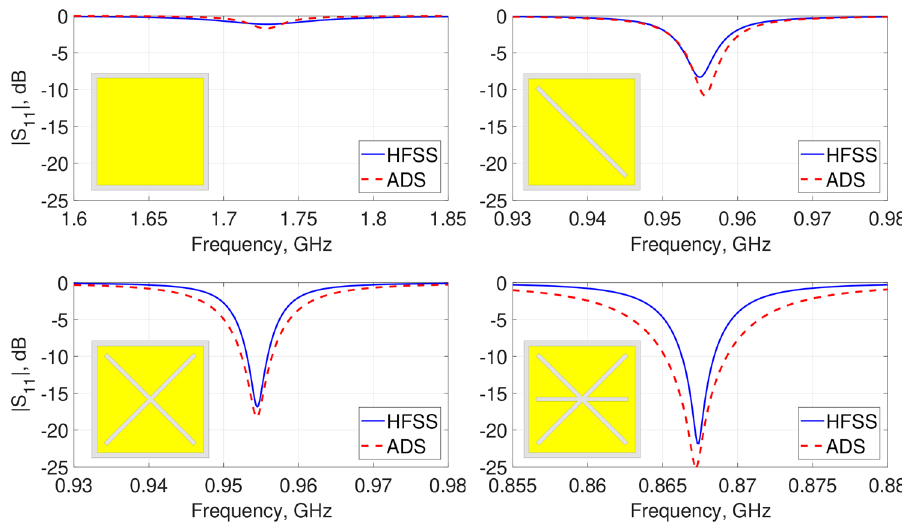
Figure 6. Simulated